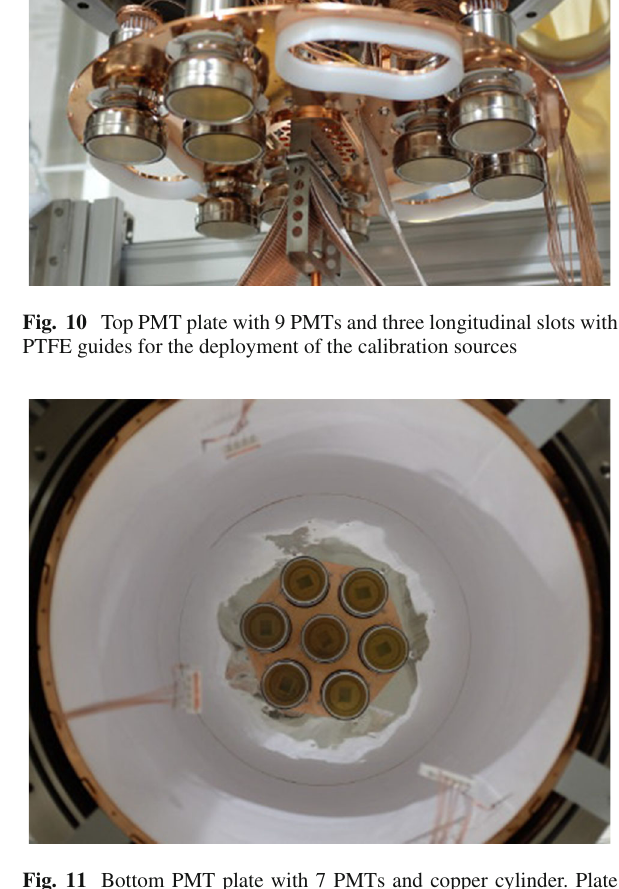
Fig. 11 Bottom PMT plate with 7 PMTs and copper cylinder. Plate and cylinder are covered by wavelength shifting Tetratex ® foil soaked in TPB [24]